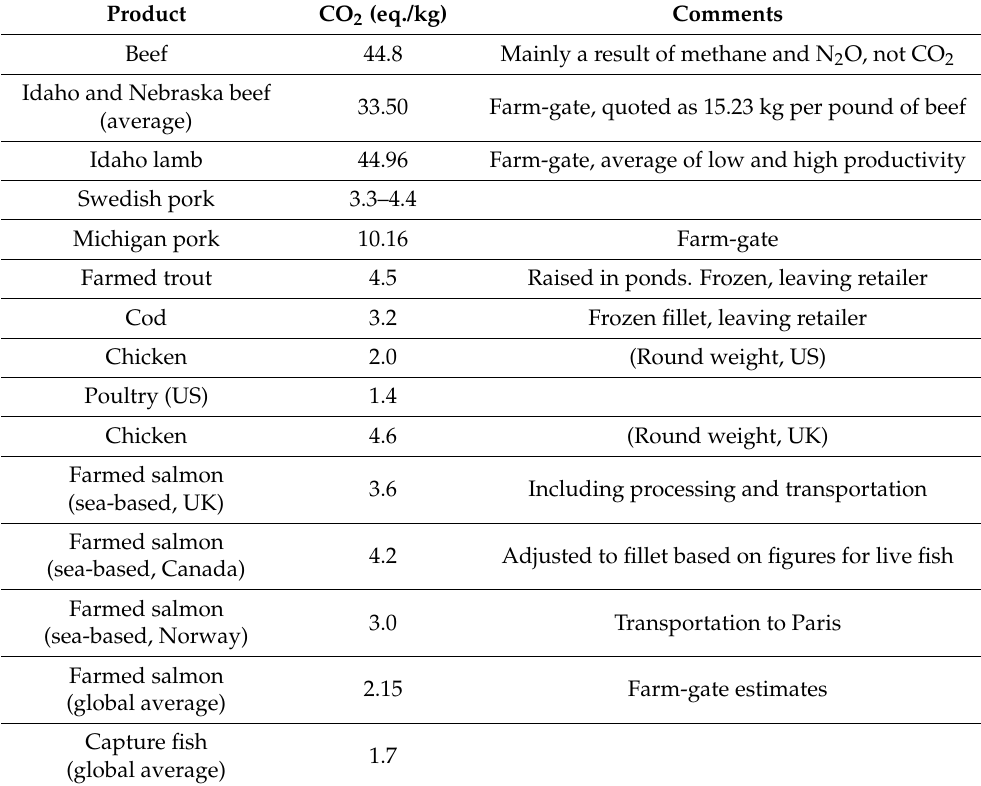
Table 2. GHG emissions for various food products and different studies. Variations within the same product category result from different farming methods, but also due to differences in LCA calculations. (Source: adapted from